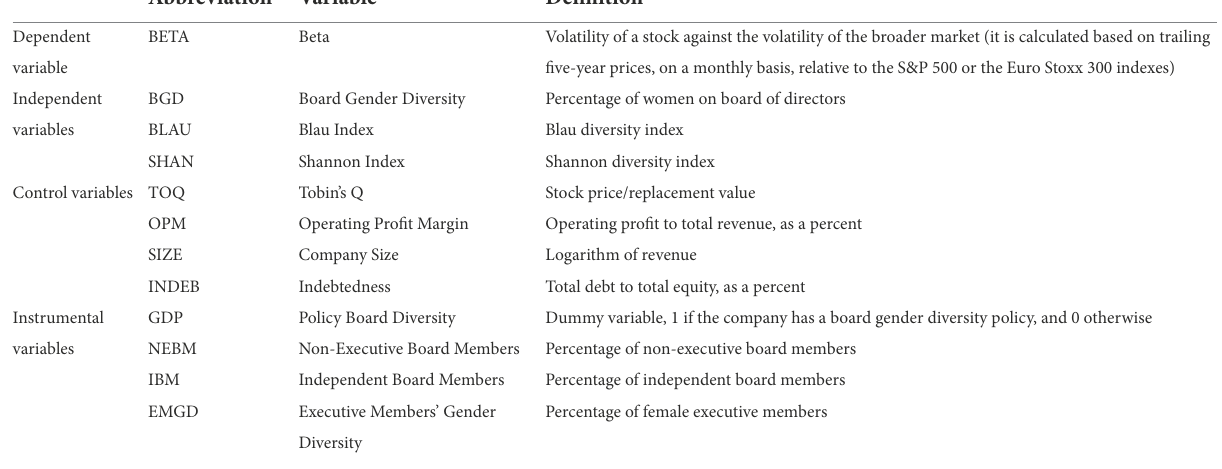
TABLE 3 Variables